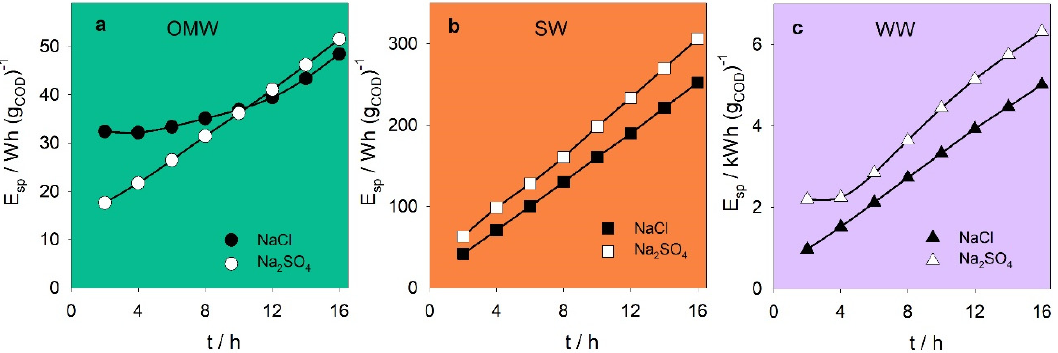
Figure 4. Specific energy consumption evolution for the electrooxidation treatment of ( a ) Olive mill wastewater (OMW), ( b ) Slaughterhouse wastewater (SW), and ( c ) Winery wastewater (WW), utilizing NaCl or Na 2 SO 4 as supporting electrolyte.